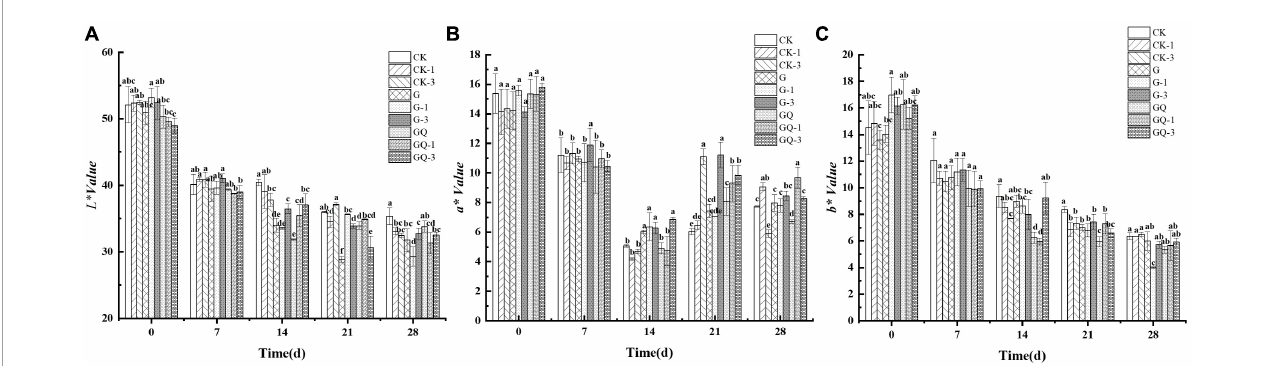
FIGURE3 Changes in the color attributes of L ∗ (A) , a ∗ (B) , and b ∗ (C) in sausages among treatments during the fermentation for 0, 7, 14, 24, and 28 days. Different lowercase letters (a–f) indicate a significant difference between different treatment groups at the same fermentation time ( P < 0.05). The group without starter culture and leucine was assigned to the CK group. The groups added with 1 and 3 mM of leucine without starter culture were assigned to the CK-1 and CK-3 groups, respectively. The group with Lactobacillus fermentum YZU-06 was assigned to the G group. The groups with Lactobacillus fermentum YZU-06 and different concentrations of leucine (1 and 3 mM) were named G-1 and G-3 groups, respectively. The fermented sausage with the mixed-starter cultures of Lactobacillus fermentum YZU-06 and Staphylococcus saprophyticus CGMCC 3475 was assigned to the GQ group. The groups with the mixed-starter cultures and different concentrations of leucine (1 and 3 mM) were named GQ-1 and GQ-3 groups, respectively.